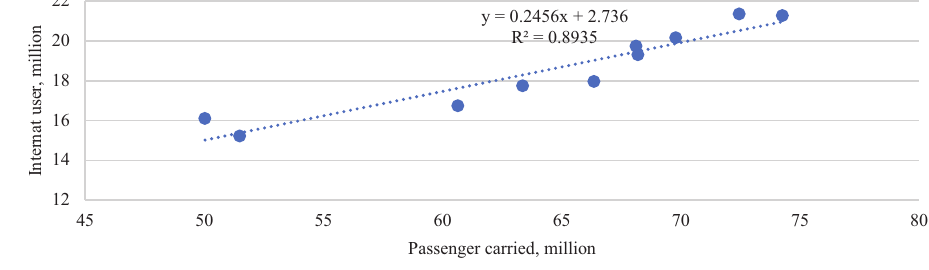
Figure 4. Regression result of passenger carried in Australia from 2008 to 2017